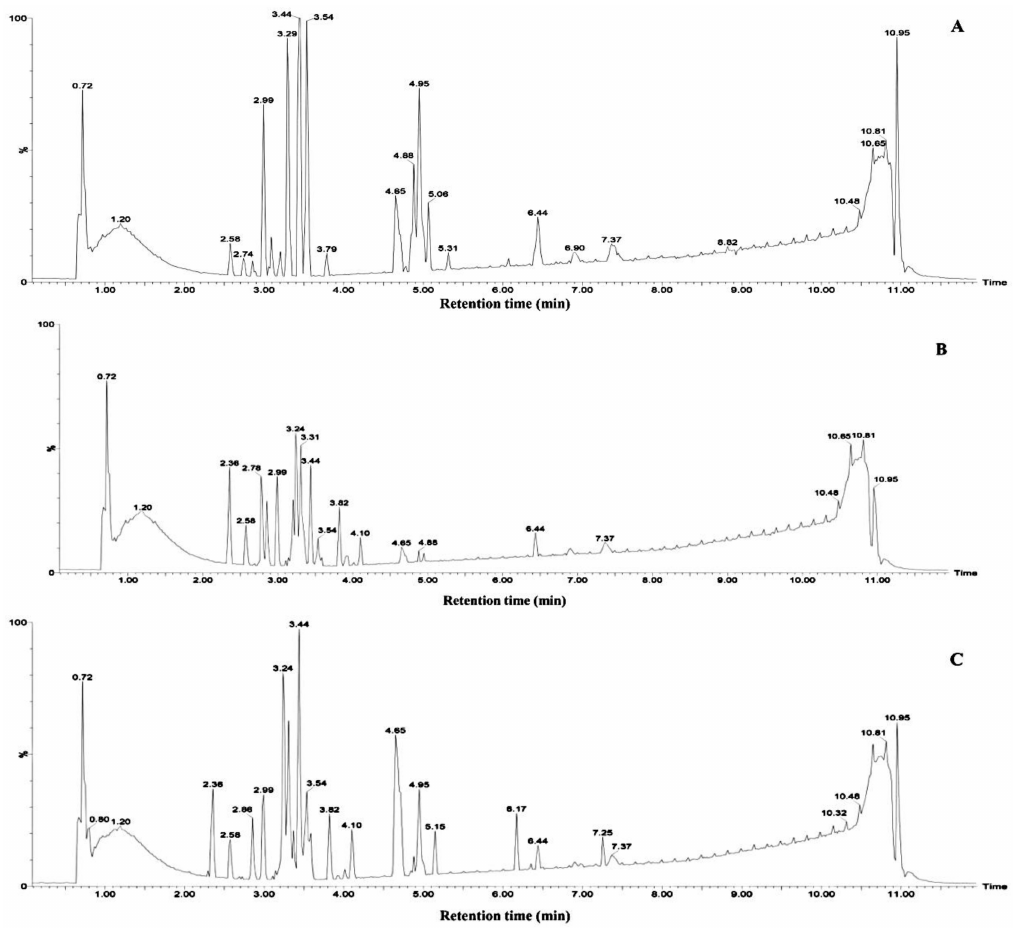
Figure 6. Identification of chemical constituents from B. gymnorrhiza leaf aqueous extracts in negative mode. ( A ) Young leaf, ( B ) Mature leaf, ( C ) Senescent leaf. Numbers above peaks represent retention times, in